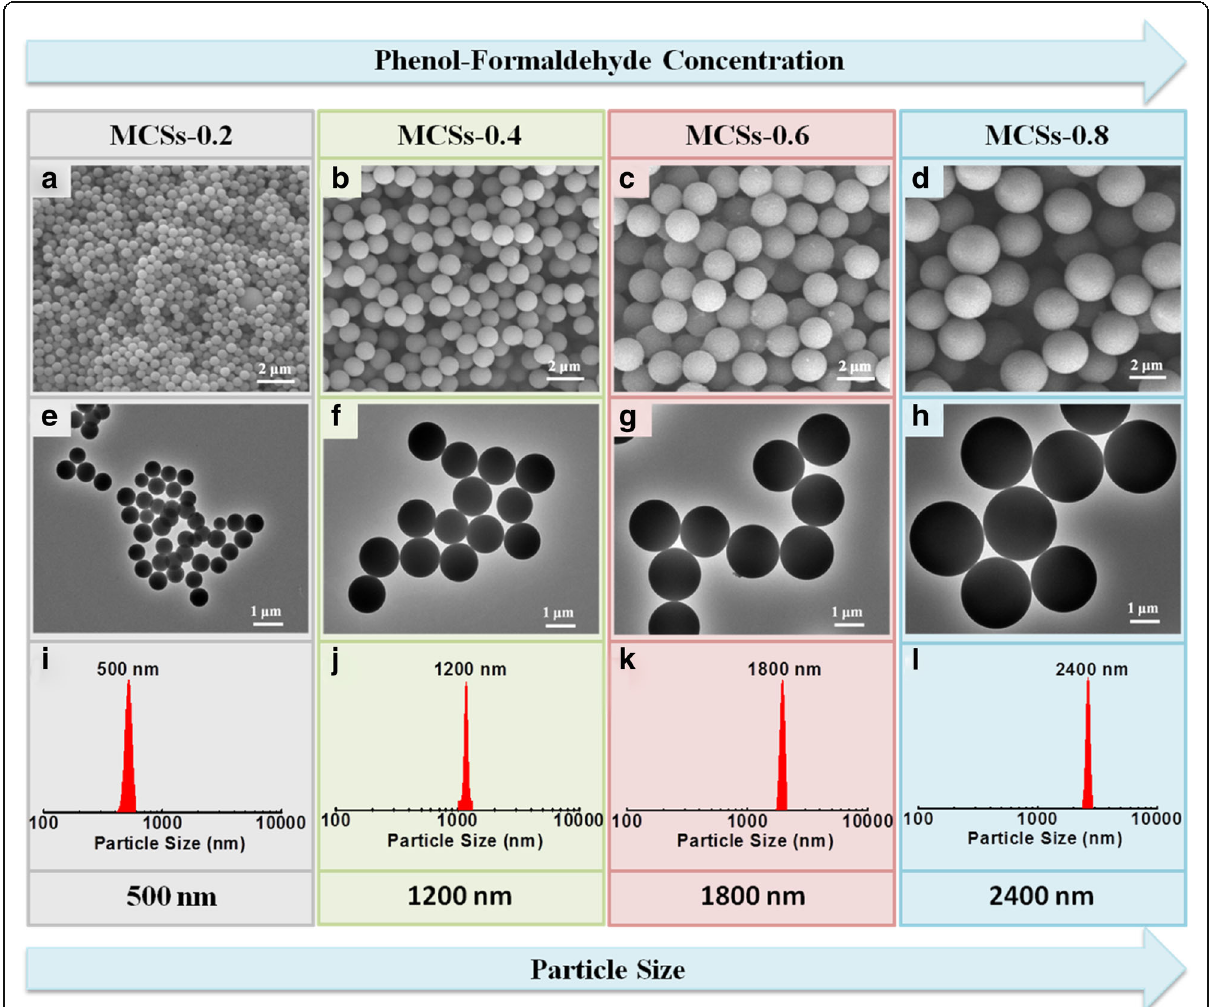
Fig. 1 SEM and TEM images of MCSs prepared at different phenol and formaldehyde dosages of a , e 0.2 mL, b , f 0.4 mL, c , g 0.6 mL, and d , h 0.8 mL, respectively. i – l The particle size distribution of MCSs corresponding to the SEM images ( a – d